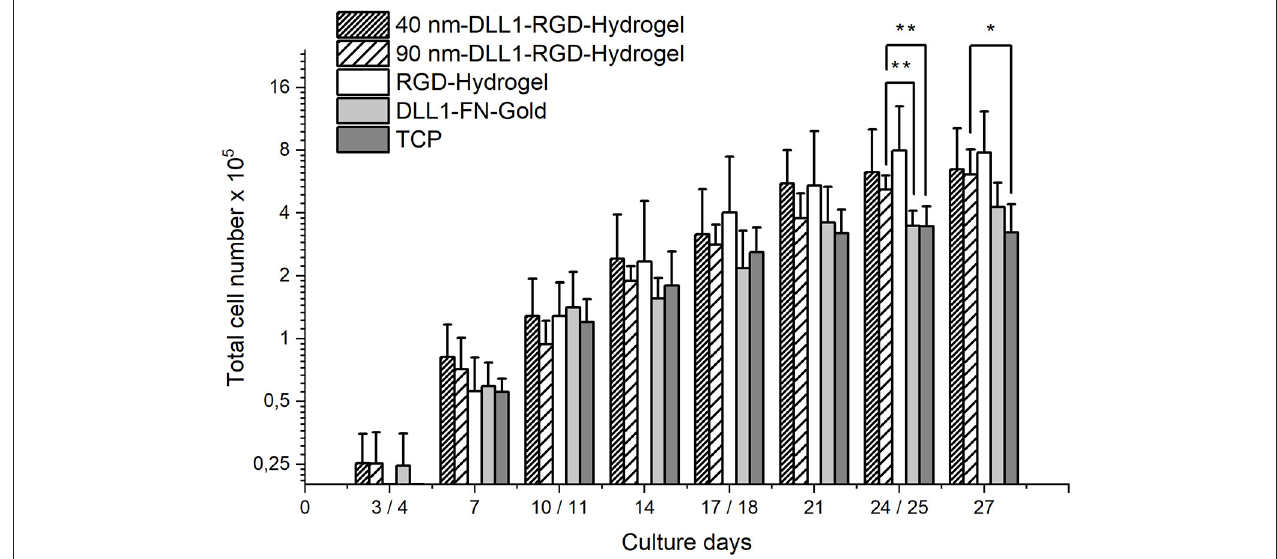
FIGURE 3 | Total number of cells cultured on bifunctional surfaces for 27 days. Cells were generated from 2 × 10 4 human UCB CD34 + cells on DLL1-nanostructured and pure RGD-PEGDA hydrogels as well as DLL1-non-structured fibronectin (FN) gold substrates. Nanostructures define a DLL1 spacing of 40 and 90nm, respectively. Viable cells were enumerated at the indicated time points. Standard culture surface is (TCP). Data represent mean (SD) cell numbers from N = 6 samples from each surface type, executed in three independent experiments. Significant differences are indicated as follows: * P < 0.05; ** P <